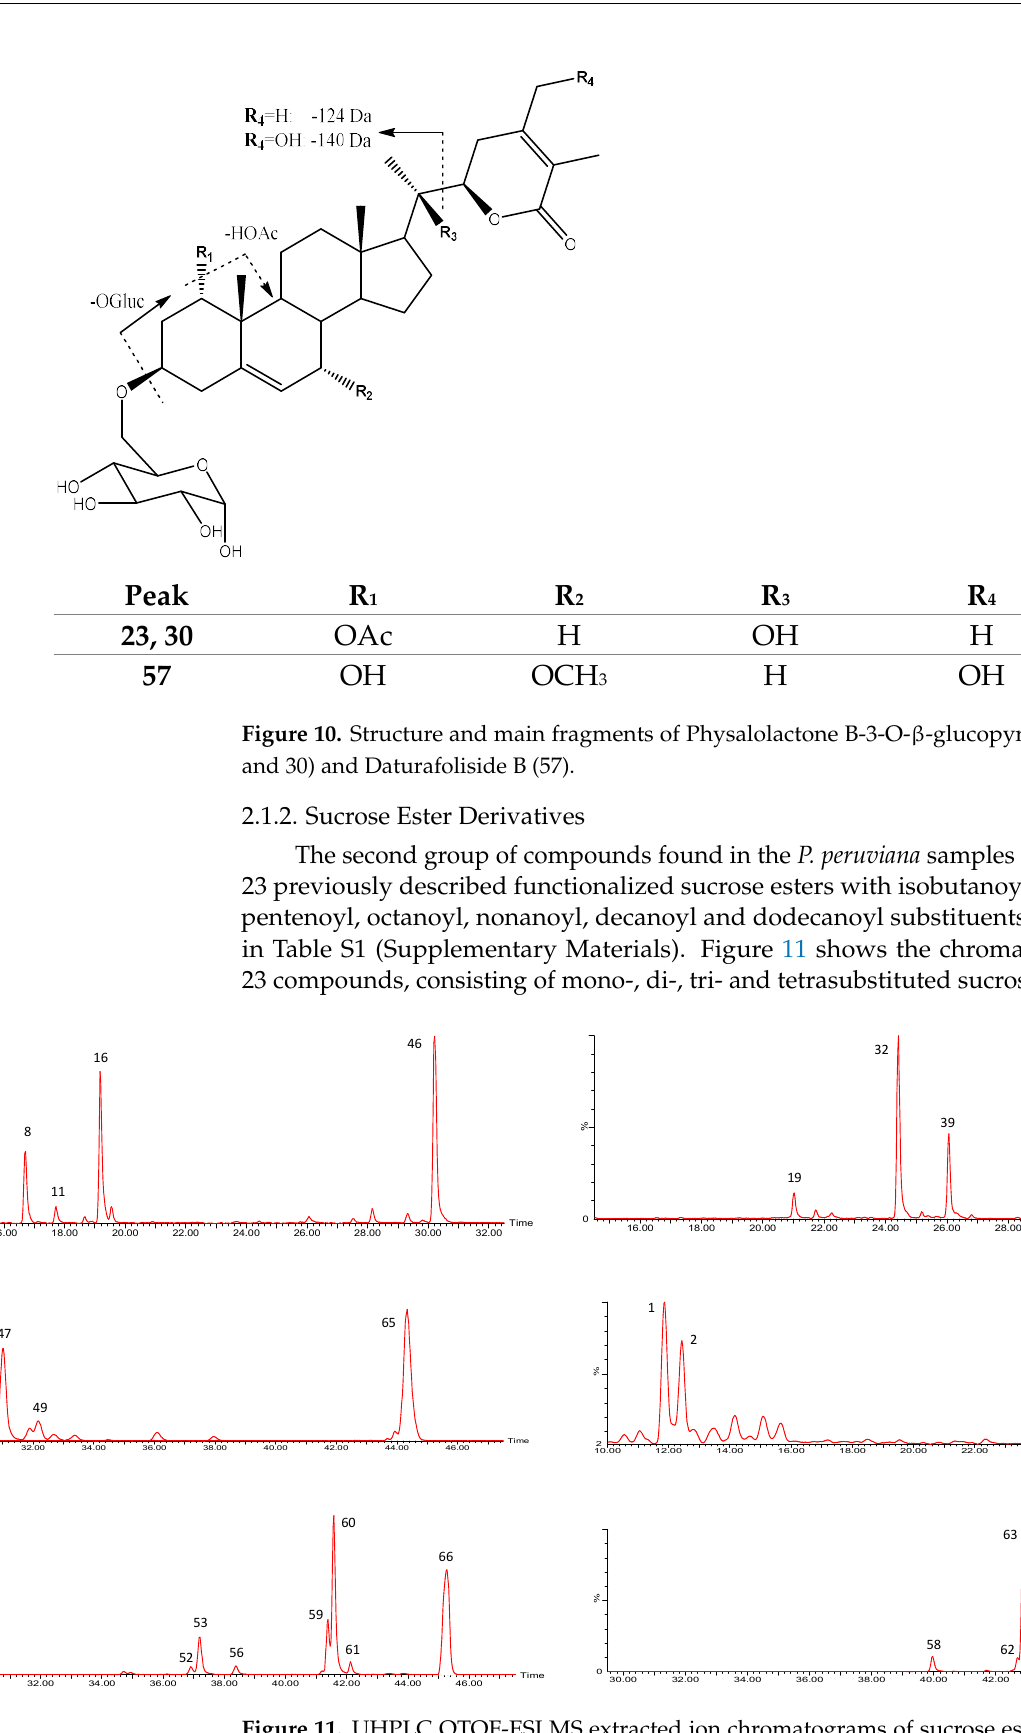
Figure 11. UHPLC QTOF-ESI MS extracted ion chromatograms of sucrose ester derivatives from P. peruviana husks and fruits.